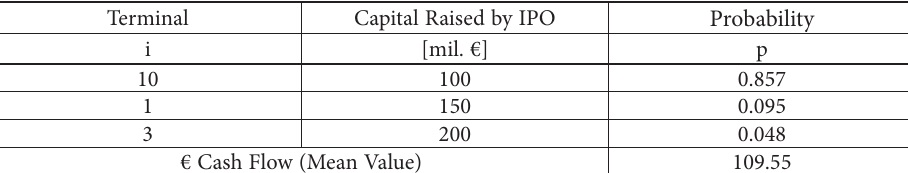
Table 5. Probabilities of the IPO success and the mean value